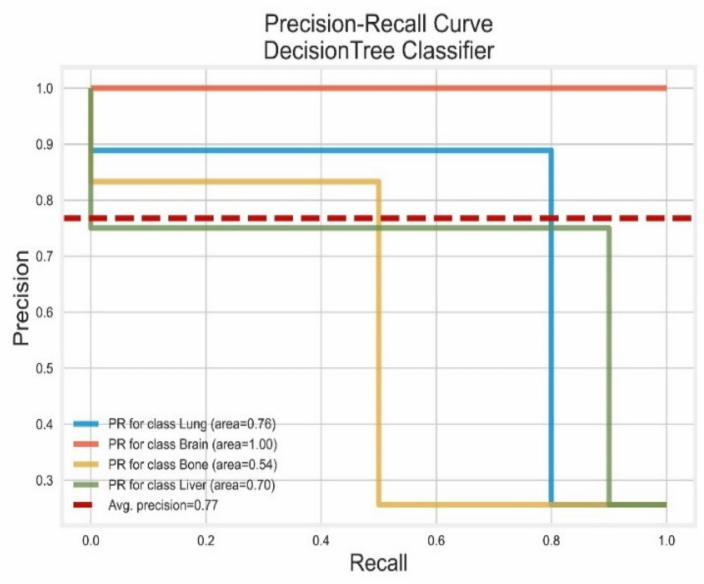
Figure 15. Precision-Recall Curve (Decision Tree Classifier).